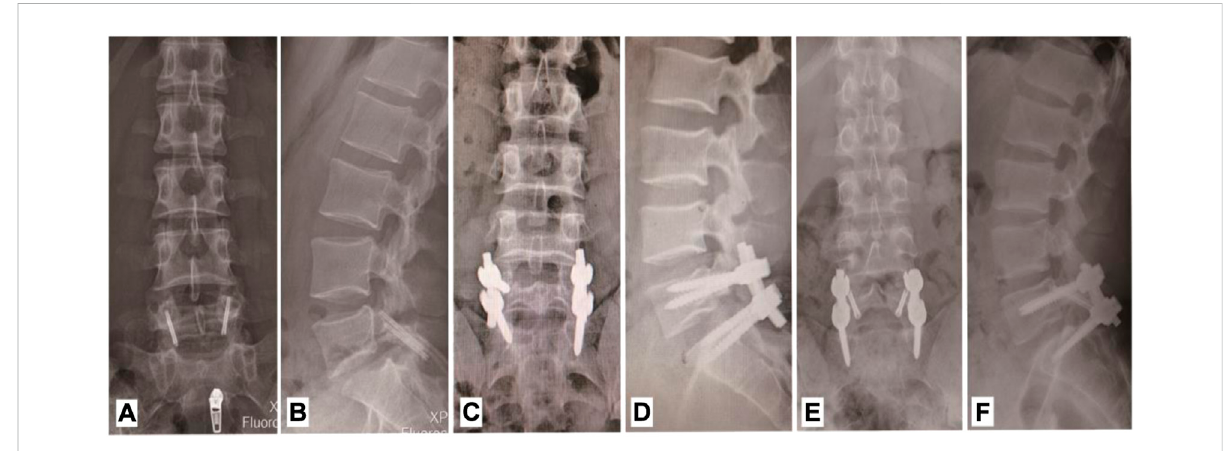
FIGURE 1 X-ray images of three internal fi xation options. (A,B) Anteroposterial-lateral radiograph with intra-segmental direct fi xation. (C,D) Anteroposterial-lateral radiograph with intra-segmental direct fi xation. (E,F) Anteroposterial-lateral radiograph with hybrid fi